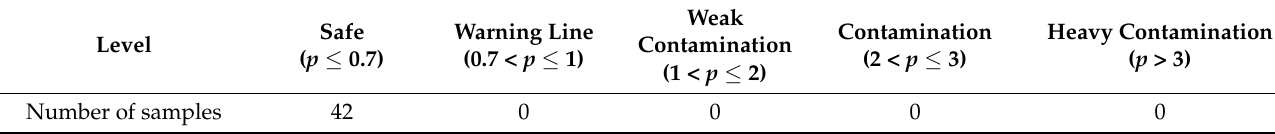
Table 5. Statistics of the Nemerow index of soil PAHs.